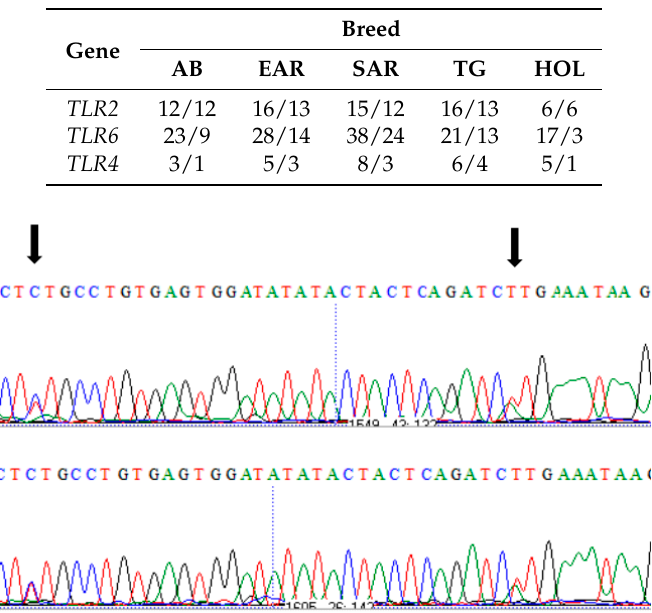
Figure 3. An example of the electropherogram, arrows showing R337Q and H326Q, respectively, in the AB breed.